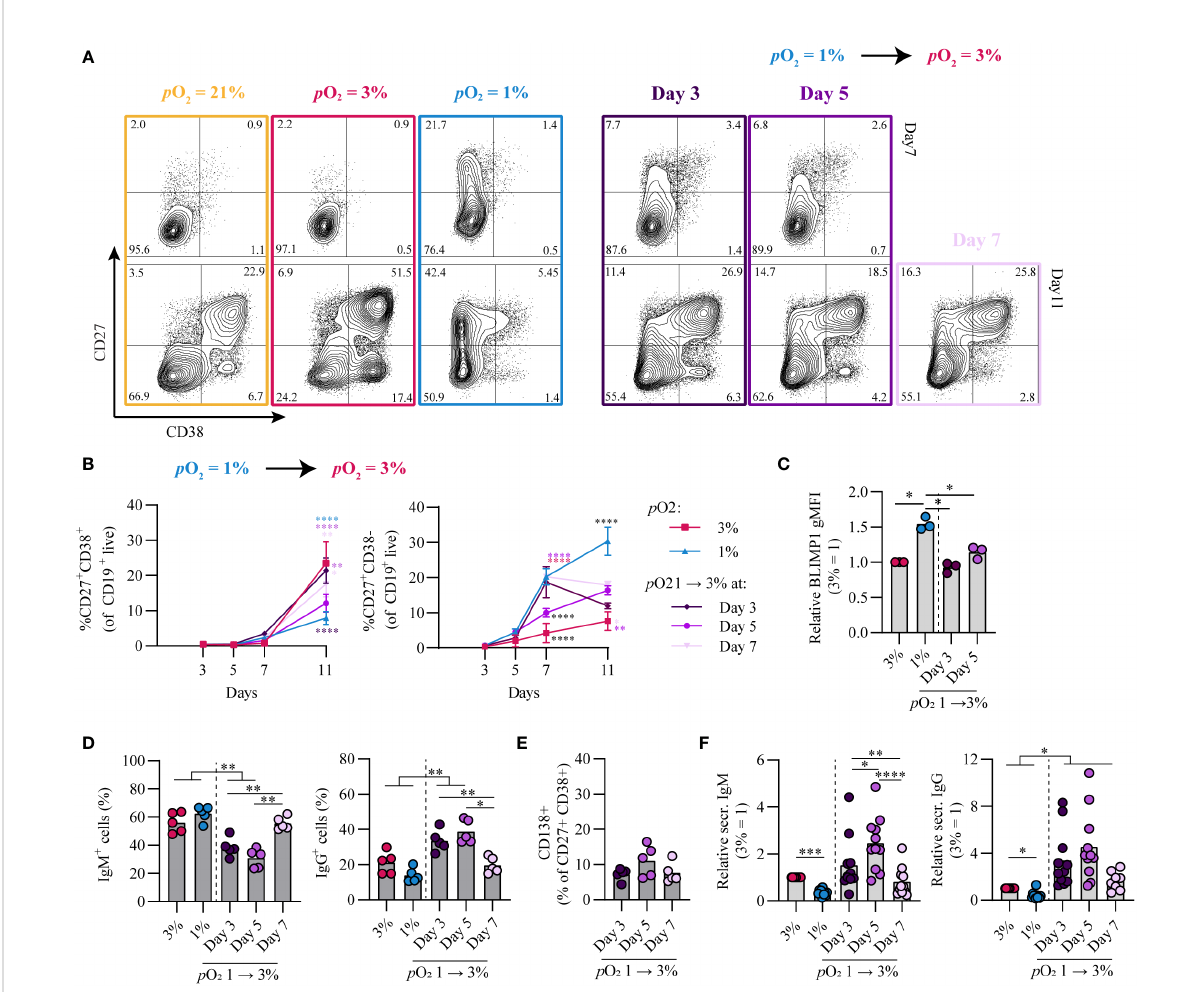
FIGURE 5 Time-dependent pO 2 transitions alter naive B cell differentiation and IgG class switch recombination. (A) Representative biaxial CD27/CD38 FACS plots of 21, 3, 1% pO2 cultures and 1 – 3% pO 2 transition cultures at day 3, 5 or 7 shown for day 7 and 11 of culture. (B) Quanti fi cation of CD27 + CD38 + and CD27 + CD38 - B cells over time in culture ( n = 11) (C) gMFI of BLIMP1 on day 7 ( n = 3) (D) Frequency of IgM + and IgG + B cells on day 11 ( n = 5). (E) CD138 expression within the CD27 + CD38 + population ( n = 5). (F) IgM and IgG levels were measured by ELISA in culture supernantant after 11 days ( n = 11). Bars represent means of biological replicates each composed of two technical replicates of (B, F) 3, (D) 2 or (C, E) 1 independent experiment. (B) Statistical differences were determined using mixed-effects analysis using Tukey ’ s test for multiple comparisons (C-F) Differences in gMFI, % gated cells and Ig production were determined using repeated measures one-way ANOVA using Tukey ’ s test for multiple comparisons. *p < 0.05, **p < 0.01, ***p < 0.001, ****p <